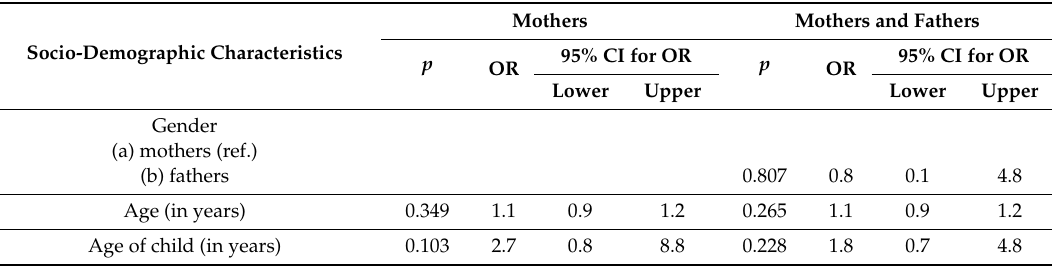
Table A4. Binary Logistic Regressions of Socio-Demographic Characteristics and Child’s Habit of Cycling to School based on the Sample of